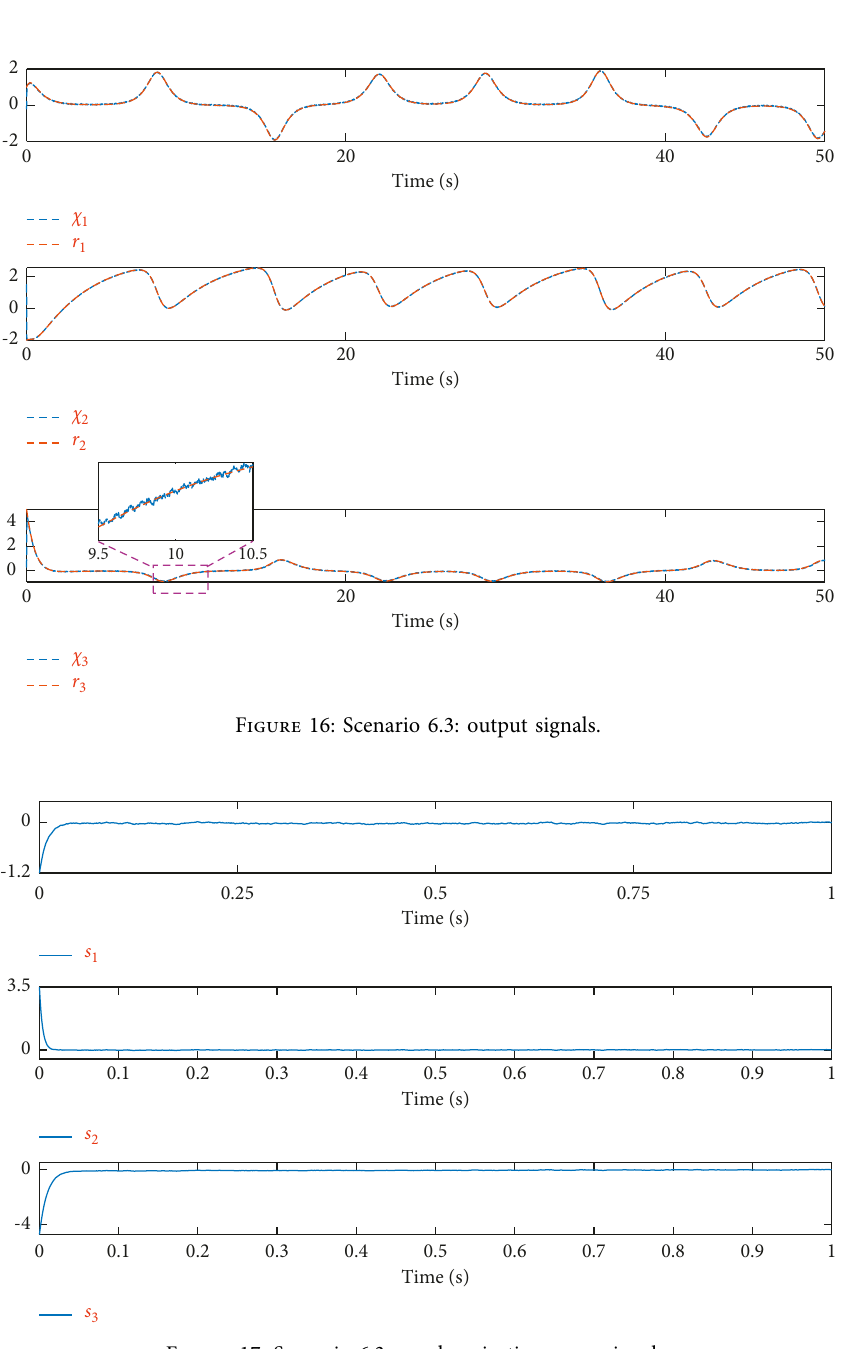
Figure 17: Scenario 6.3: synchronization error